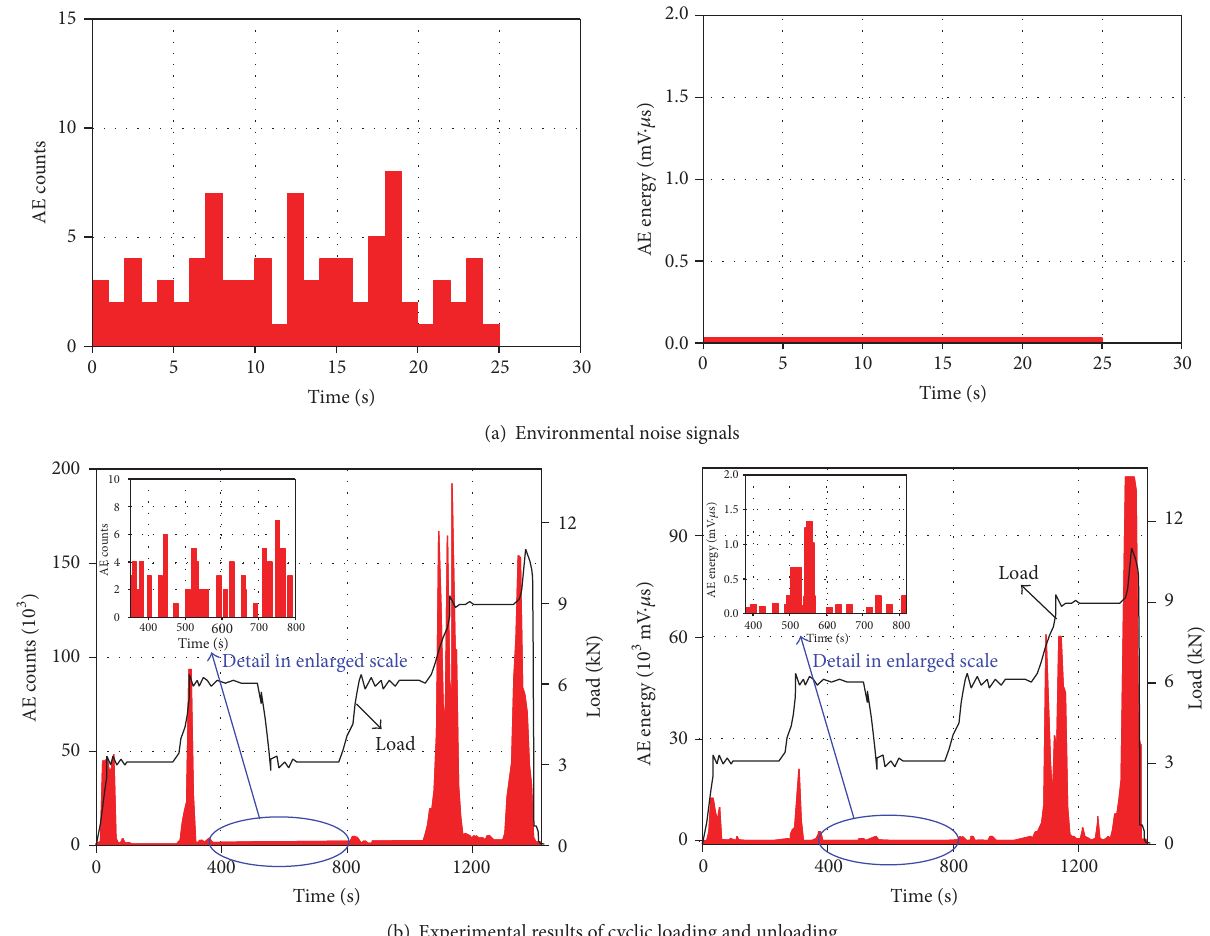
Figure 4: The AE filtering experiment results of coal under loading and